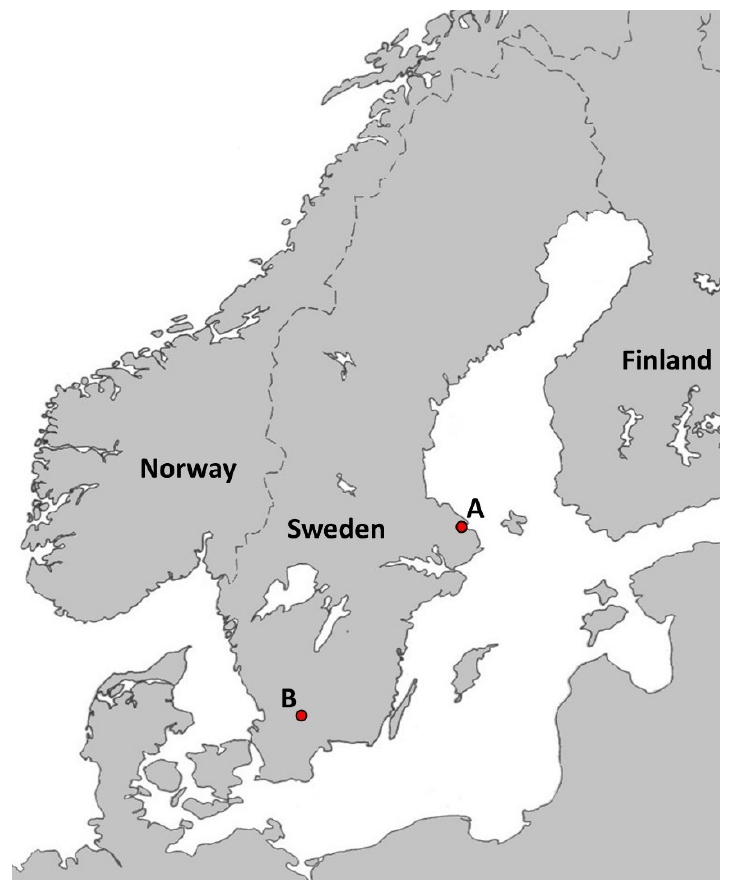
Figure 1. Map showing the localities where ticks were collected. ( A ) 91 ticks were collected from a water-filled tray placed below a wooden bat box located at Snesslinge (60°19.567 N, 18°15.067 E) in the province of Uppland, south-central Sweden. ( B ) One tick was collected inside a house located at Älmhult (56°32.720 N, 13°52.667 E) in the province of Småland, southern Sweden. The distance between A and B is 483 km.